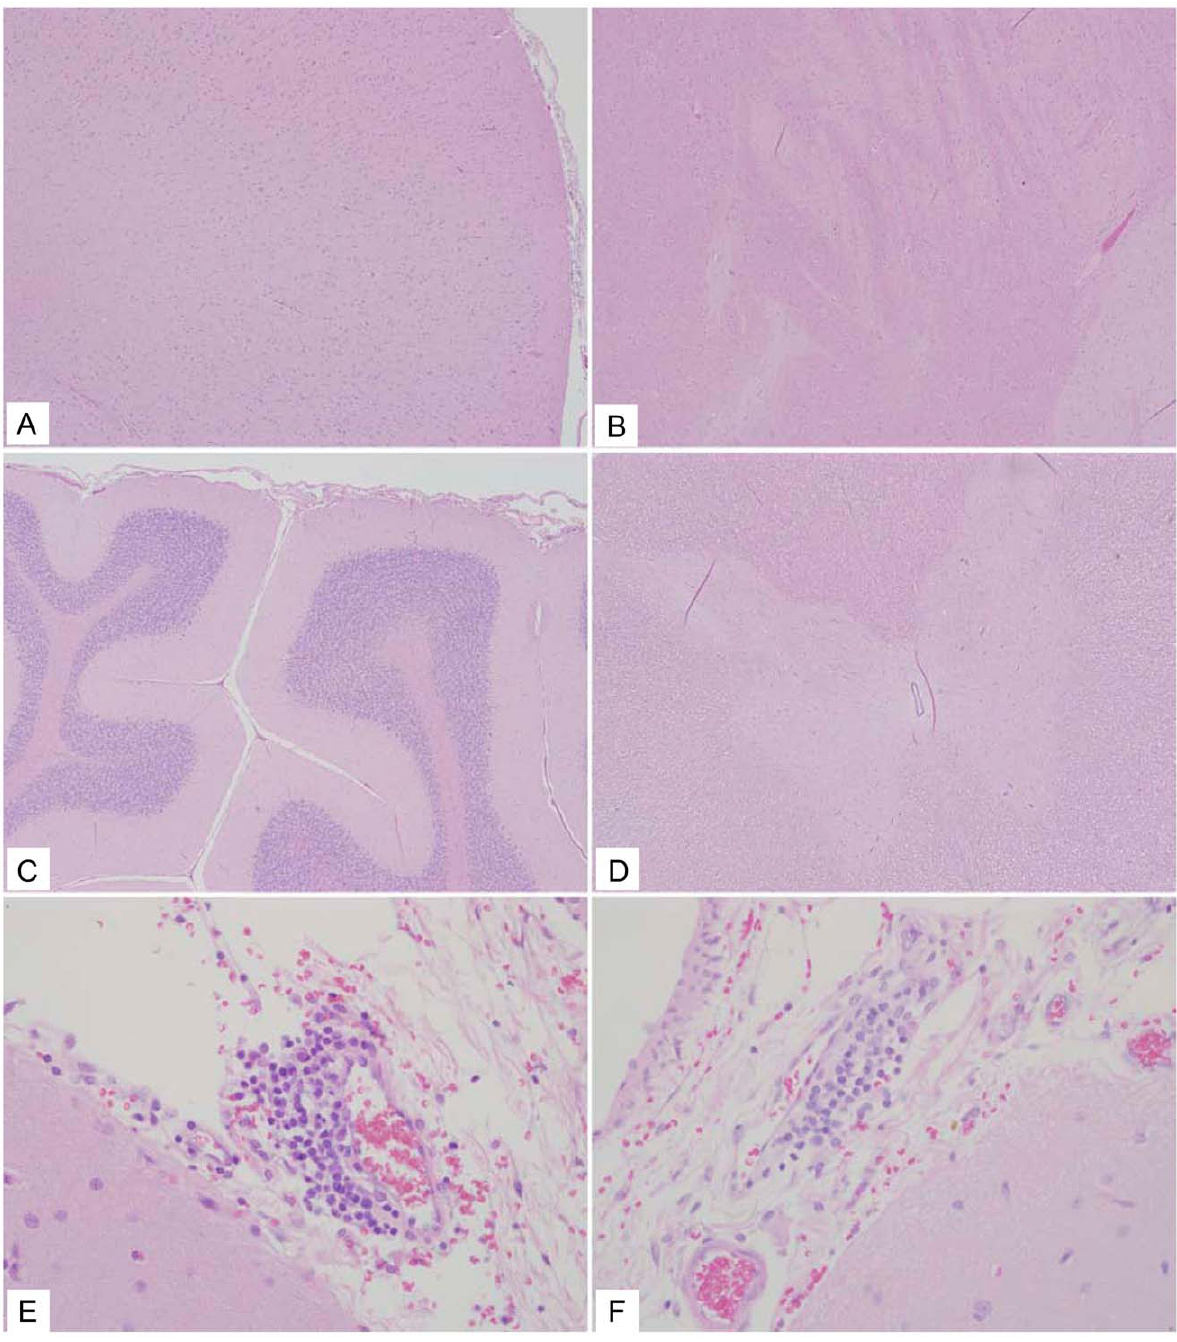
Figure 4. Representative rVSV-ZEBOV-GP histology. (A and B) Frontal cortex (10 6 ) sections with no lesions. (C) Cerebellum (10 6 ) section with no lesions. (D) Spinal cord (10 6 ) section with no lesions. (E) Frontal cortex (40 6 ) section with a mild perivascular cuff of lymphocytes. (F) Occipital cortex (40 6 ) section with a mild perivascular cuff of lymphocytes.